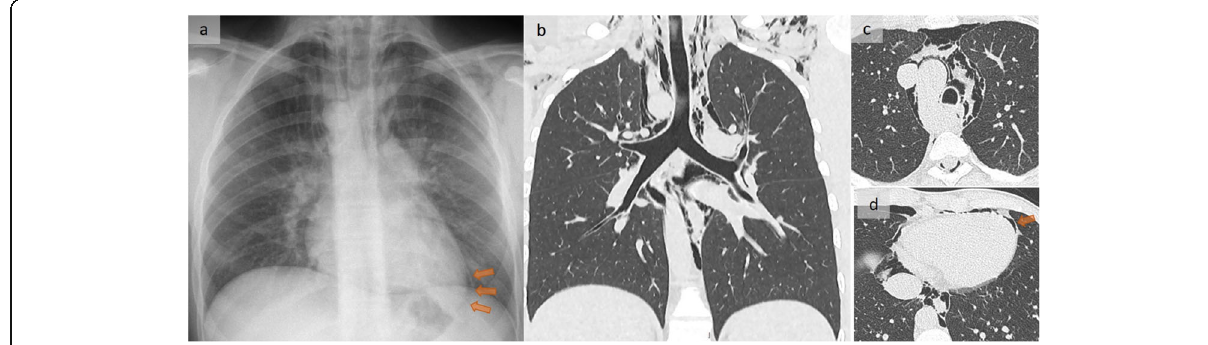
Fig. 1 Atraumatic pneumomediastinum. A patient with sudden spontaneous retrosternal and interscapular pain. Frontal chest X-ray ( a ), coronal oblique reformation in lung windowing ( b ), and axial slices ( c , d ) show gas outlining the mediastinal structures, with pneumopericardium (orange arrows in a and d ) appearing as a left paracardiac subtle line in a and subcutaneous emphysema. Note the right aortic arch. Conservative management led to a favorable